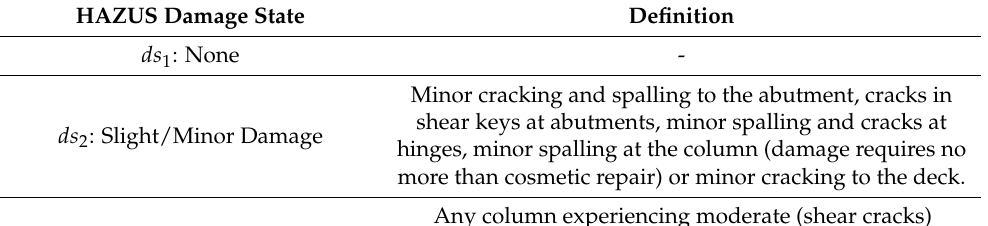
Table 1. Definition of 5 bridge damages states according to HAZUS